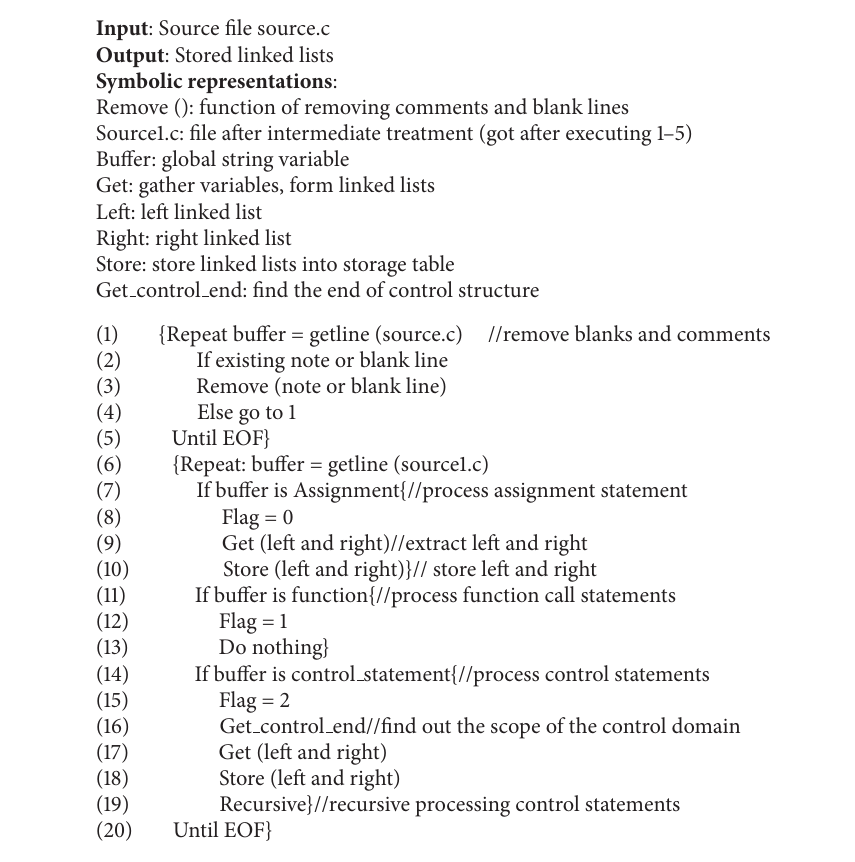
Algorithm 1: Data dependent extraction algorithm (source.c).